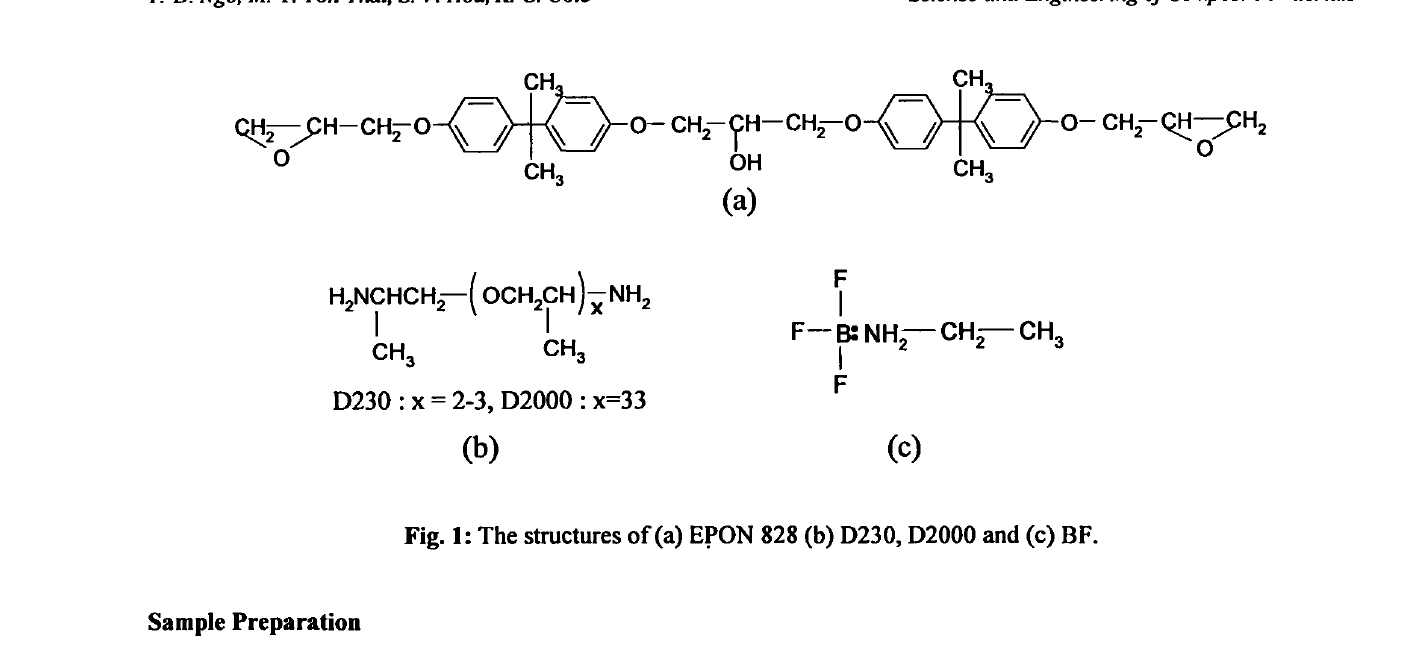
Fig. 1: The structures of (a) EPON 828 (b) D230, D2000 and (c)